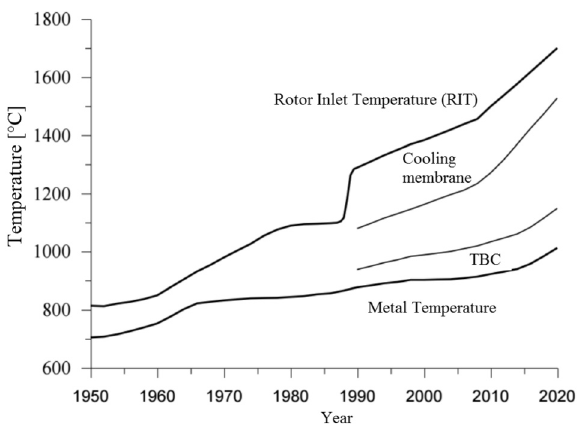
Fig. 6. Increase in the temperature of exhaust gas and blades material in gas turbines [4] Rys. 6. Wzrost temperatury spalin oraz materiału łopatek w turbinach gazowych